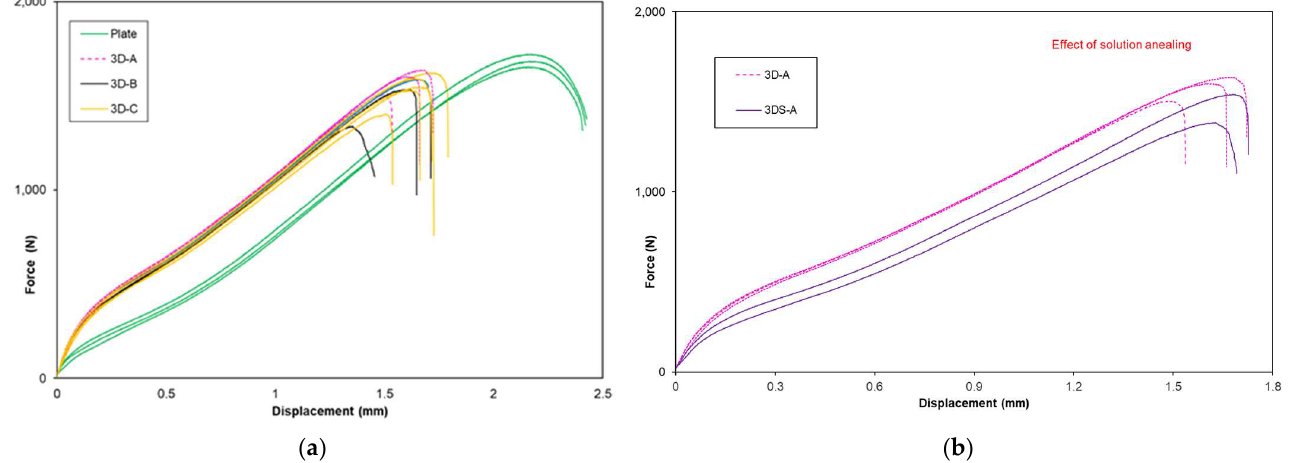
Figure 3. SPT load–displacement curves: ( a ) differences between 3D and plate; ( b ) effect of solution treatment on 3D-printed material.